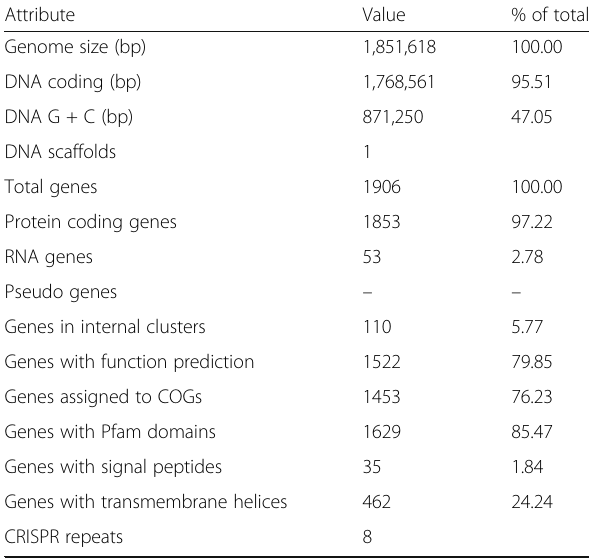
Table 4 Genome statistics according to the MGAP